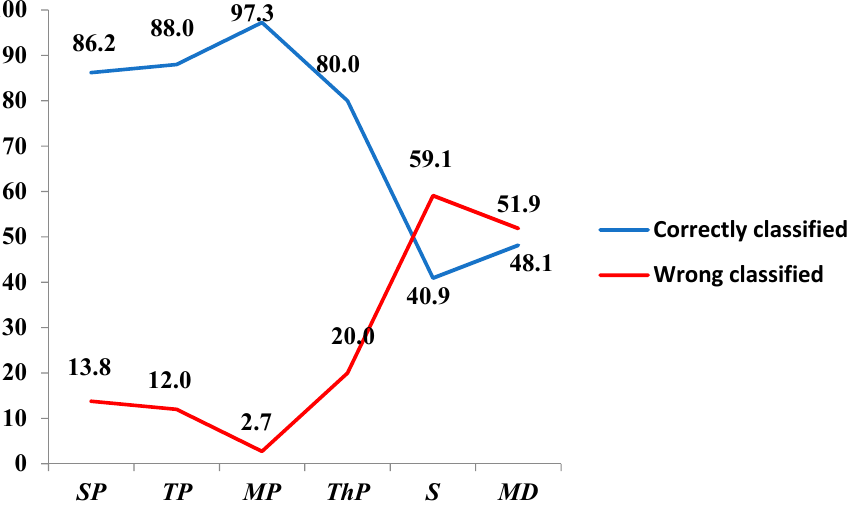
Figure 3. Percentage of correctly- and wrong-classified plots with the first DA. (Legend: SP : seedling